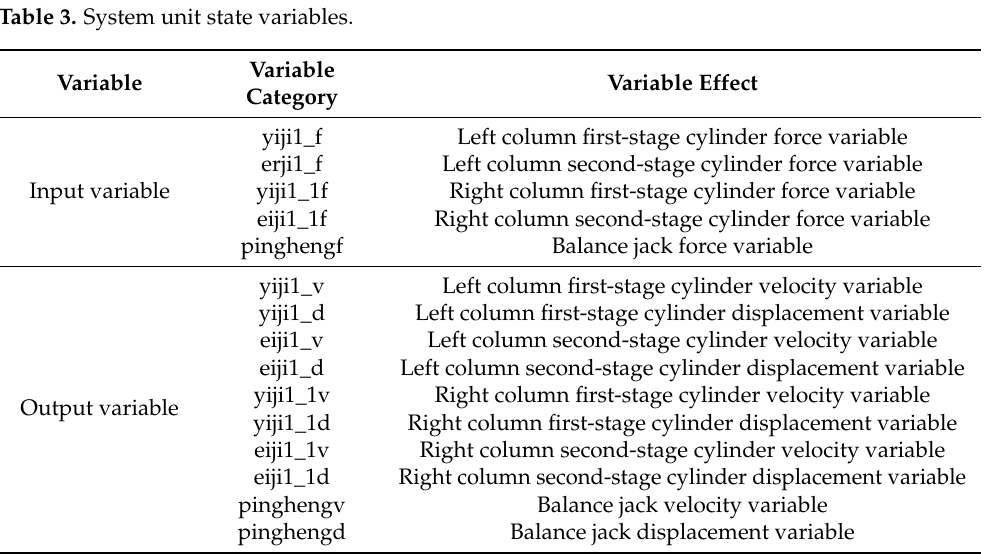
Table 3. System unit state variables.